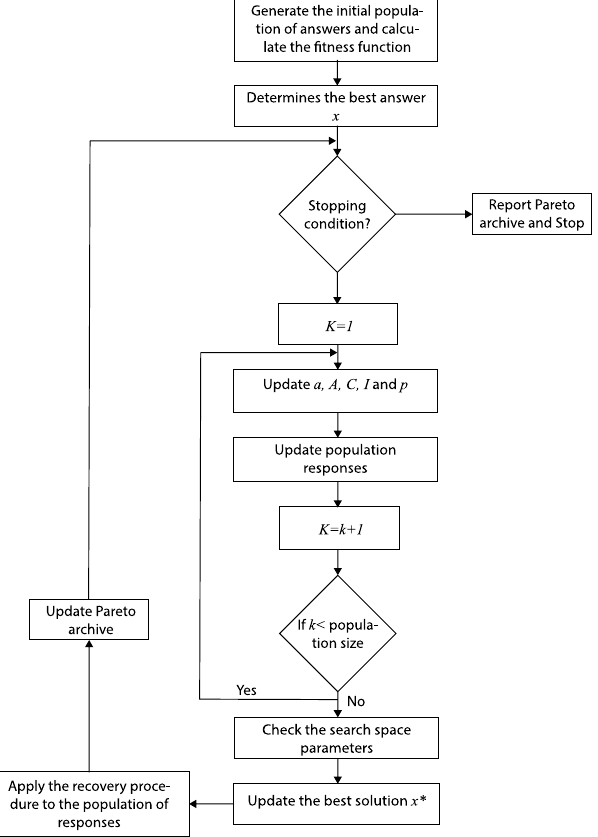
Figure 1. Proposed flowchart for the whale optimization